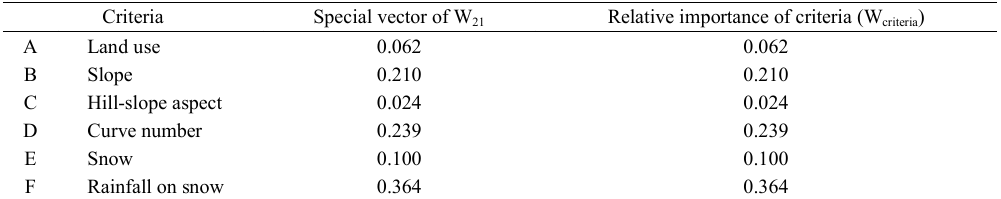
and relative importance of criteria (W 21